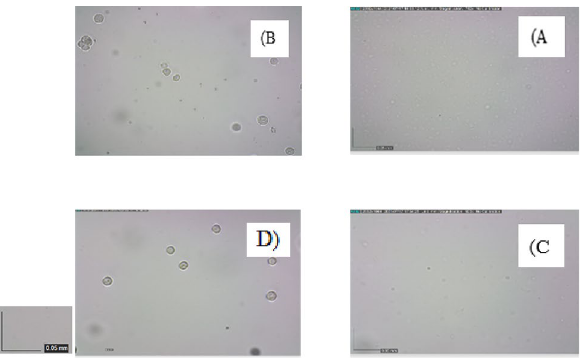
Figure 9. Experiment results for cells separation at golden flow rate. ( A ) and ( B ) illustrate the row samples of white and cancer cells without any pre-processing, respectively ( C ) illustrates the desired outlet for white blood cells (smaller cells) and ( D ) illustrates the desired outlet for cancer cells (bigger cells) at the 1.7 mL/min. In this flow rate, more than 90% of both CTCs and WBCs separate and purify.